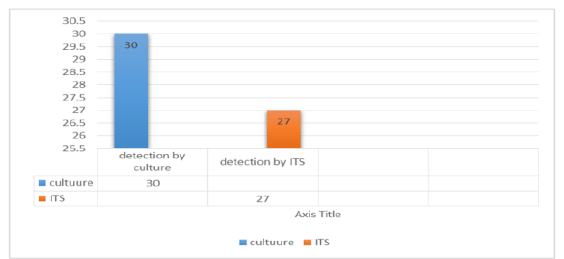
Fig. 10. Result of culture compared to conventional PCR(ITS) technique